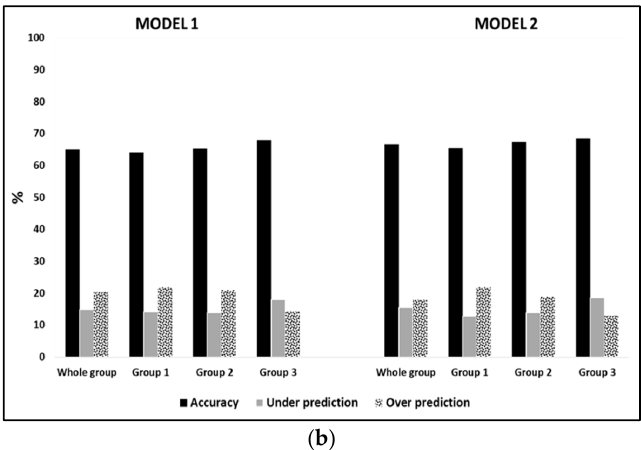
Figure 1. Prediction accuracy for REE measurements within ± 10% using the new predictive equations (model 1 and 2, Equations (1)–(4)) in 153 males ( a ) and 350 females ( b ) with obesity as well as in the BMI subgroups (Group 1 = 30–39.9 kg/m 2 ; Group 2 = 40–49.9 kg/m 2 ; Group 3 > 50 kg/m 2 ).